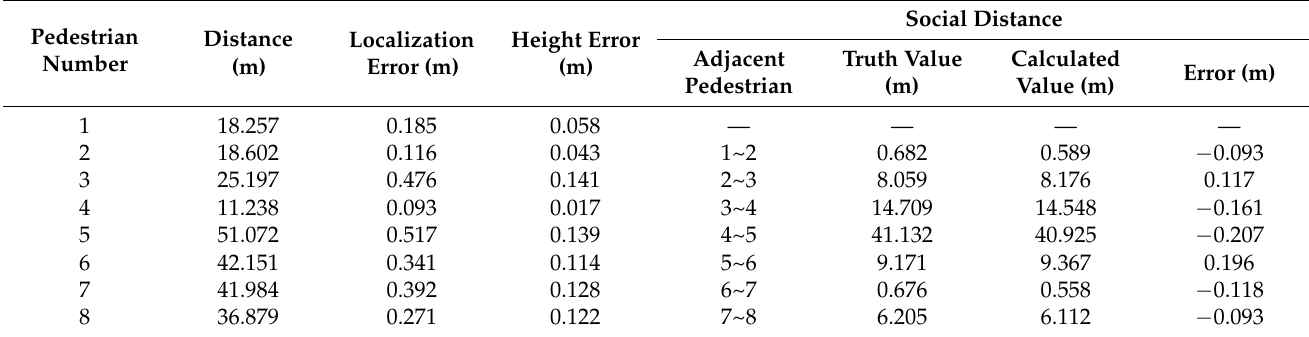
Table 3. Pedestrian localization and height errors of Scene 2 in CUMTB-Campus.